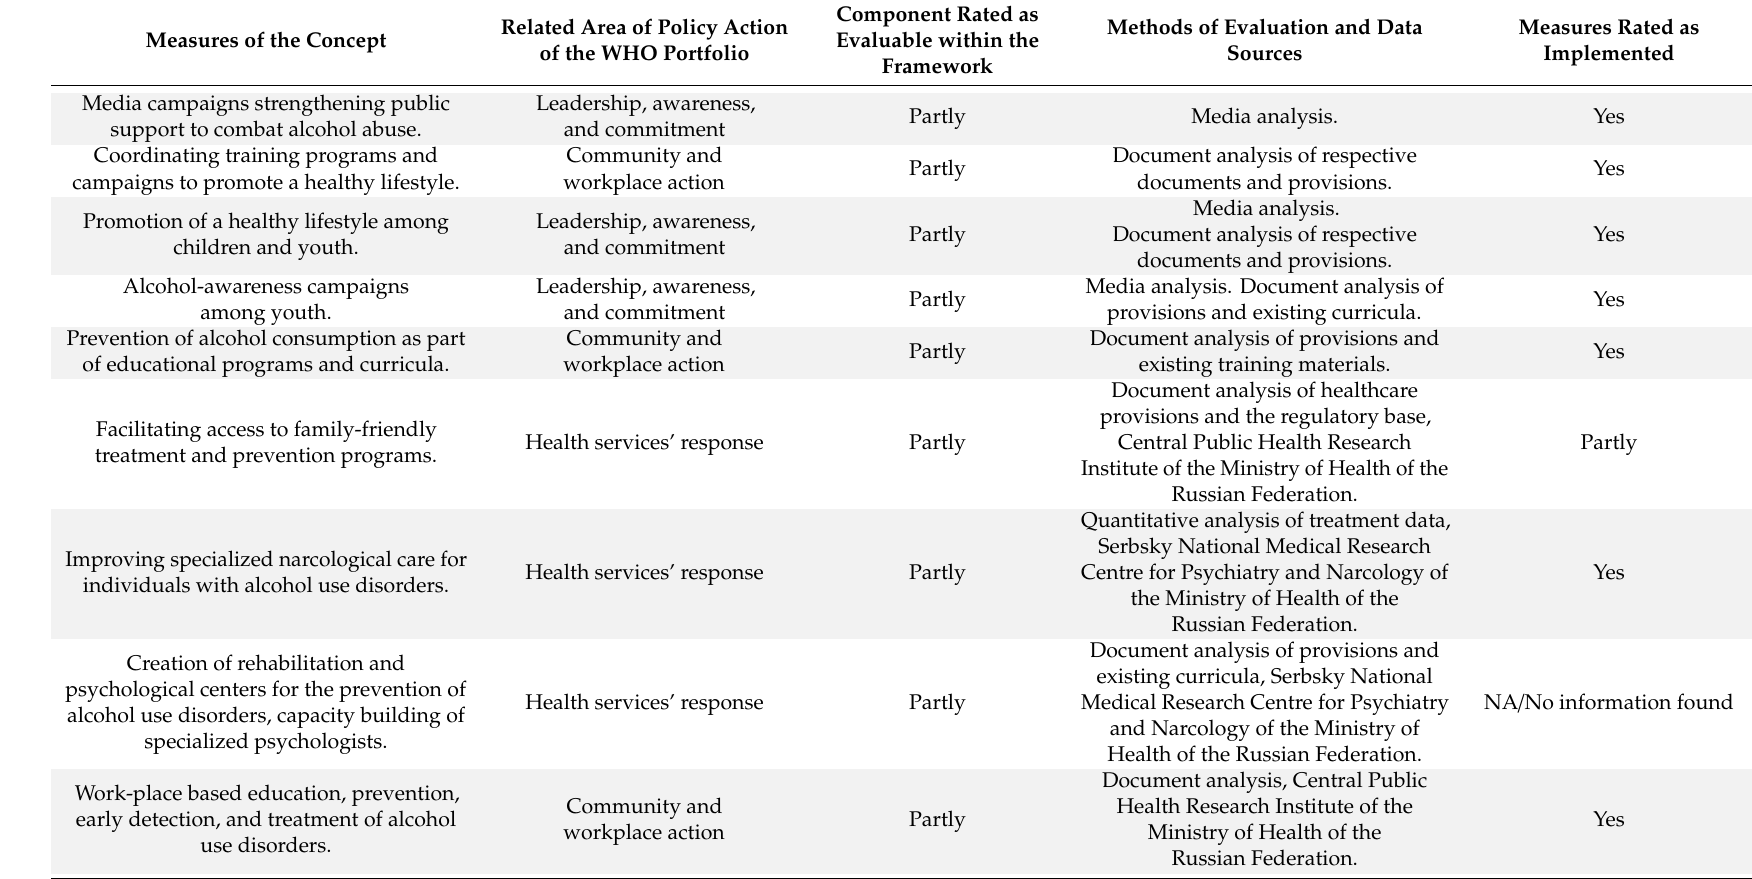
Table 1. Overview of the measures of the concept and rating of their implementation (process